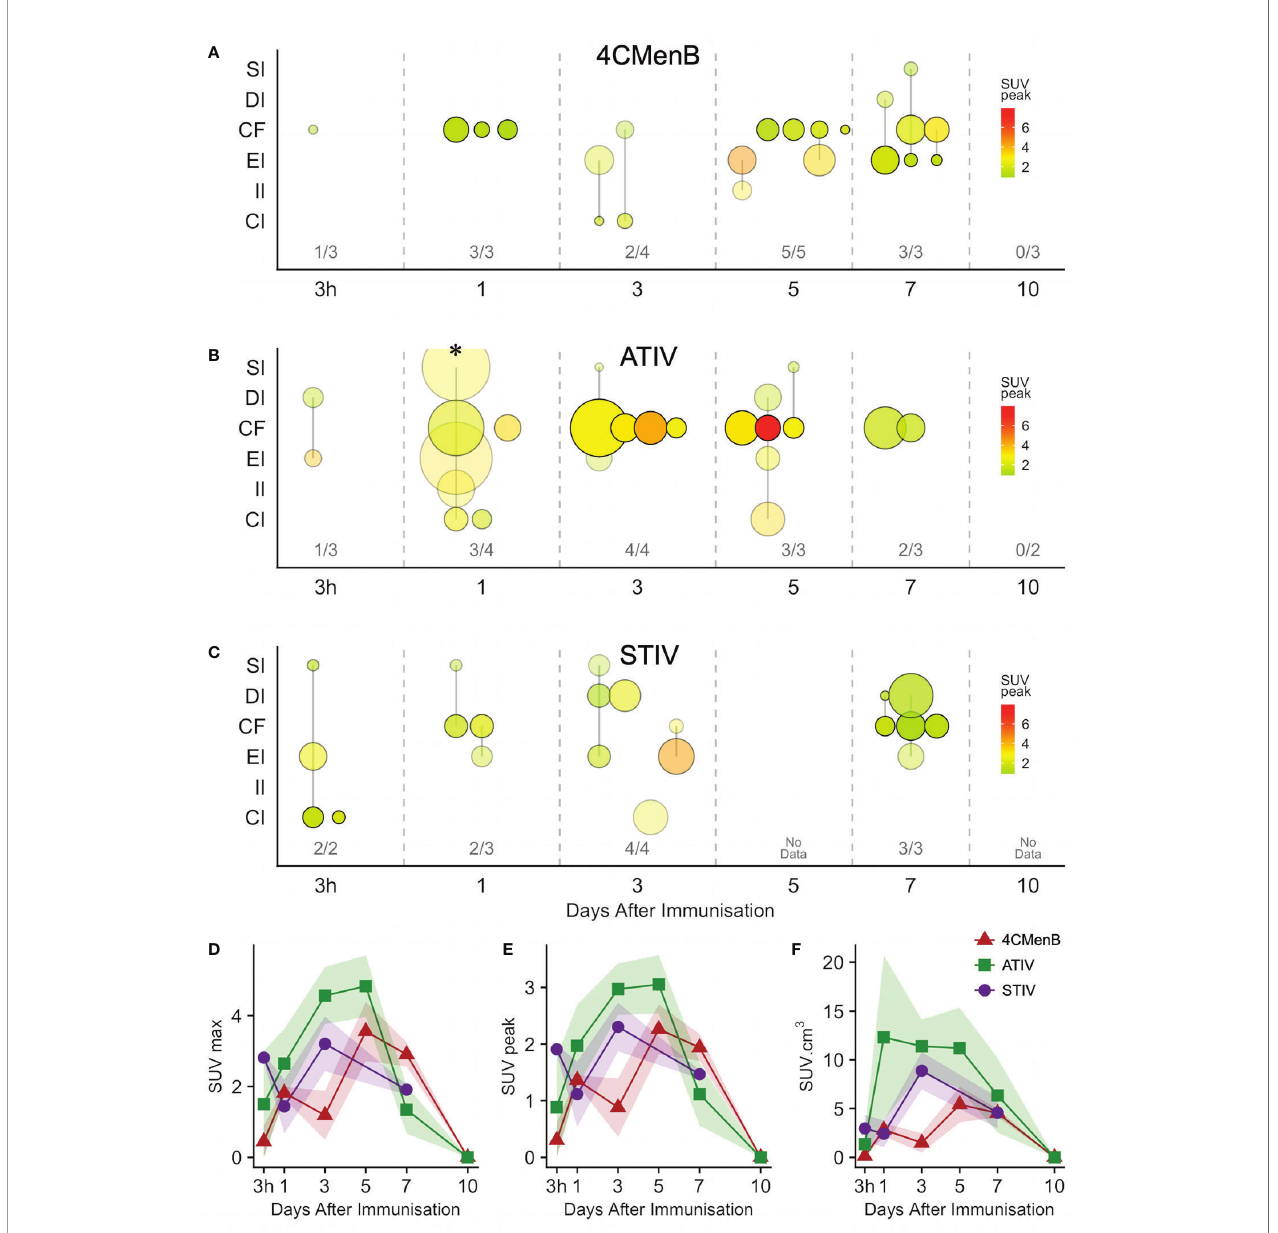
FIGURE 5 | Anatomical distribution and kinetics of lymph node 18 F-FDG PET activity after immunization. (A – C) bubble chart of lymph node 18 F-FDG PET activity after immunization with 4CMenB (A) , ATIV (B) or STIV (C) . X axis: time between scan and immunization (3 h, 1 - 10 days). Y axis: anatomical lymph node group: SI - super fi cial inguinal; DI - deep inguinal; CF - common femoral; EI - external iliac; II - internal iliac; CI - common iliac. Bubble diameter: lymph node volume; bubble transparency: proportion of participants with detectable lymph node activity in each anatomical group per time point; bubble color: SUVpeak. Figures above X axis: number of participants with detectable lymph node activity at each time point per total participants in group. (D – F) Group mean SUVmax (D) , SUVpeak (E) and total lymph node glycolysis (SUVmean x volume), (F) at different time points after immunization with 4CMenB (red triangles), ATIV (green squares) or STIV (purple circles). Shaded area: SEM. * participant with widely disseminated lymph node activity ( Figure 1D